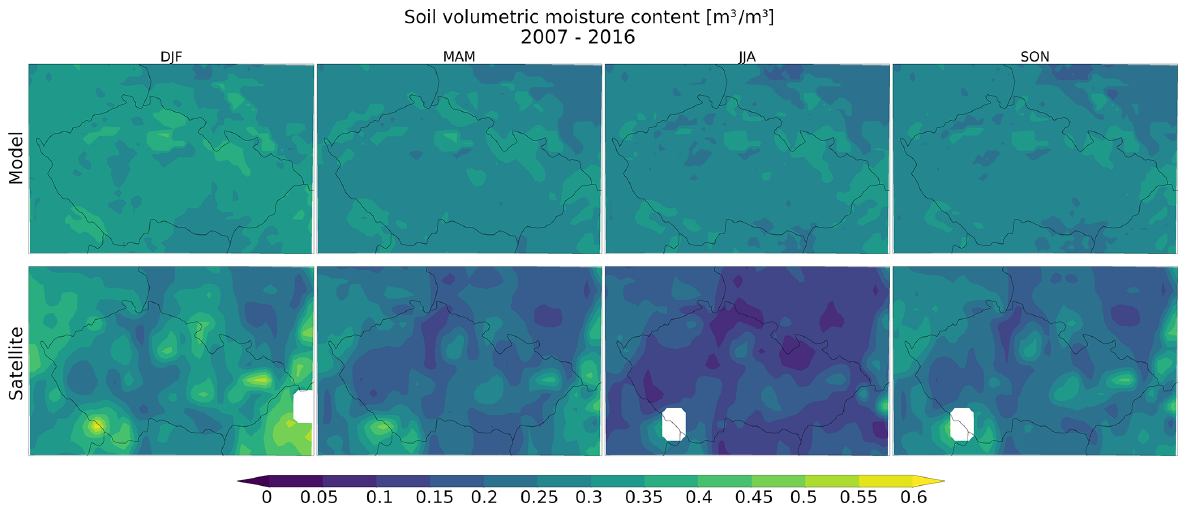
Figure 9. Comparison of modelled seasonal volumetric soil moisture (upper row) with the ESA CCI soil moisture data (lower row) for the area of Czechia. Data averaged over 2007–2016. Units are cubic metres per cubic metre.